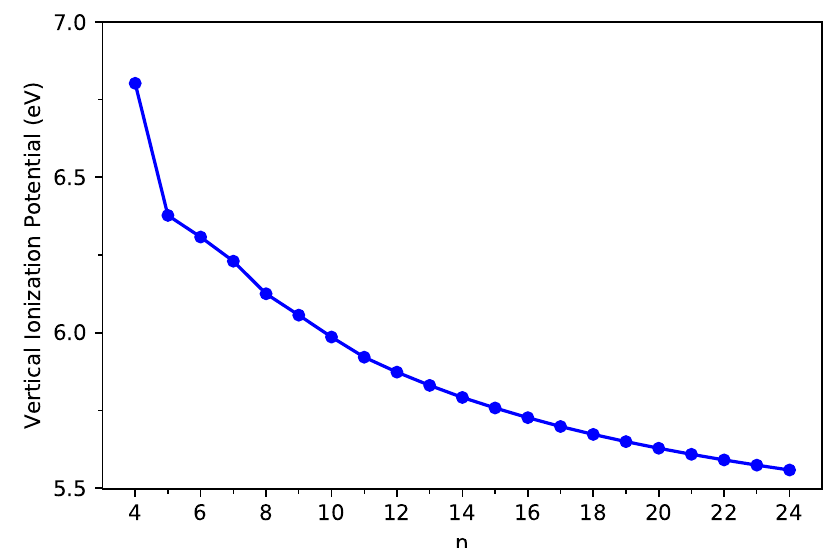
Figure 3. Vertical ionization potential of ground-state C-Belt[ n ], computed using spin-unrestricted